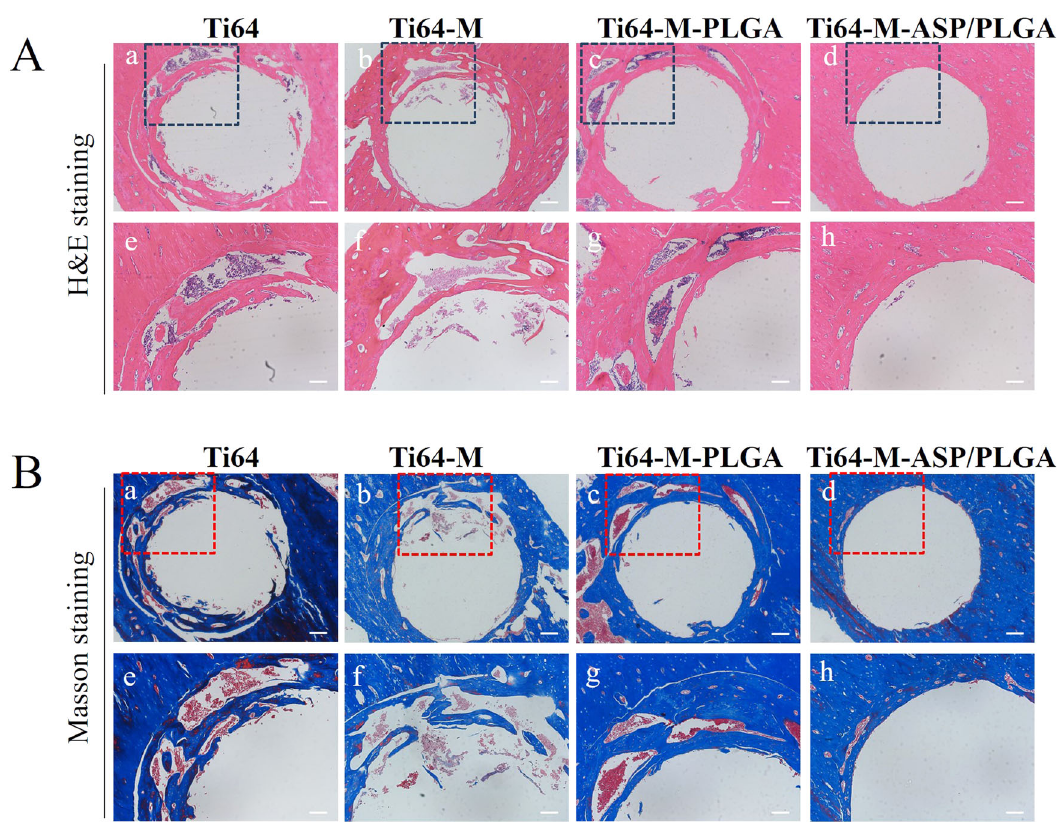
Fig. 8 Bone formation ability evaluation using histological staining. A H&E and B Masson staining images after 4 weeks of implantation. Scale bars indicate 0.2 mm (a, b, c, d) and 0.1 mm (e, f, g, h) in both ( A ) and ( B